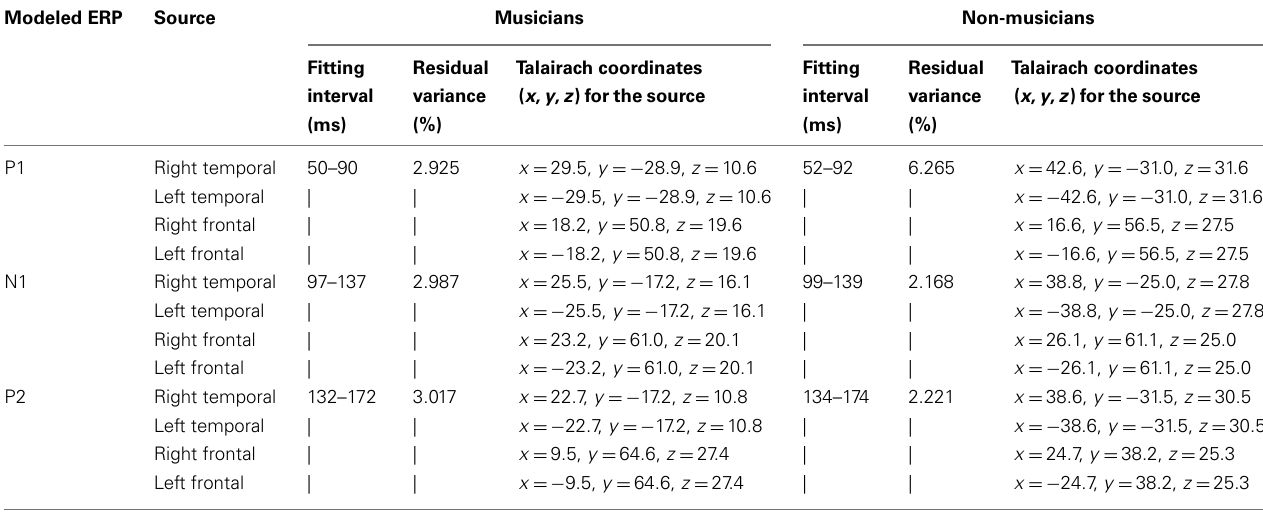
Table 1 | Fitting intervals (ms), residual variance (%), andTalairach coordinates for grand average seed source models for musicians and